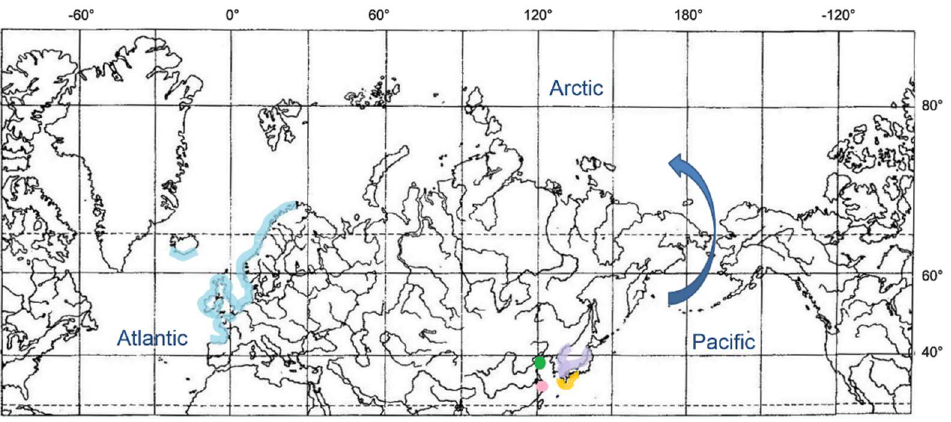
Figure 1. Distribution of “ L. montagui ” group in the Atlantic: blue line− L. montagui ; in the Pacific: green dot− L. petchiliensis , pink dot− L. chefuensis , lilac line− L. punctulatus, and yellow line− L. burkei ; arrow shows the most probable direction of the preglacial pathway.